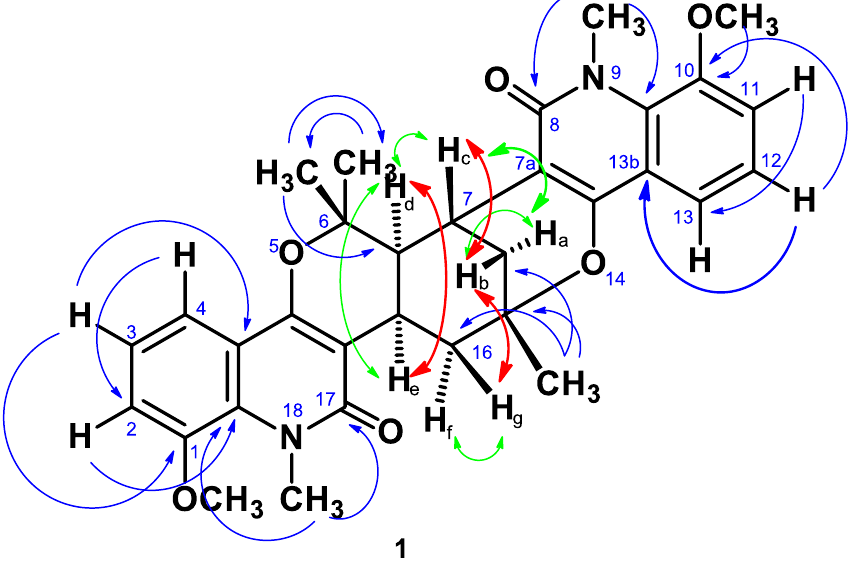
Figure 2. Key HMBC (blue), COSY (green) and NOESY (red) correlations for Compound 1 . Compound ( 2 ), 1 H NMR (400 MHz, CDCl 3 ): 7.76 dd ( J = 8.0, 1.1 Hz, H-5), 7.20 ddd ( J = 8.6, 8.0, 1.4 Hz, H-6), 7.48 ddd ( J = 8.6, 8.4, 1.1 Hz, H-7), 7.30 d ( J = 8.4 Hz, H-8), 3.34 d